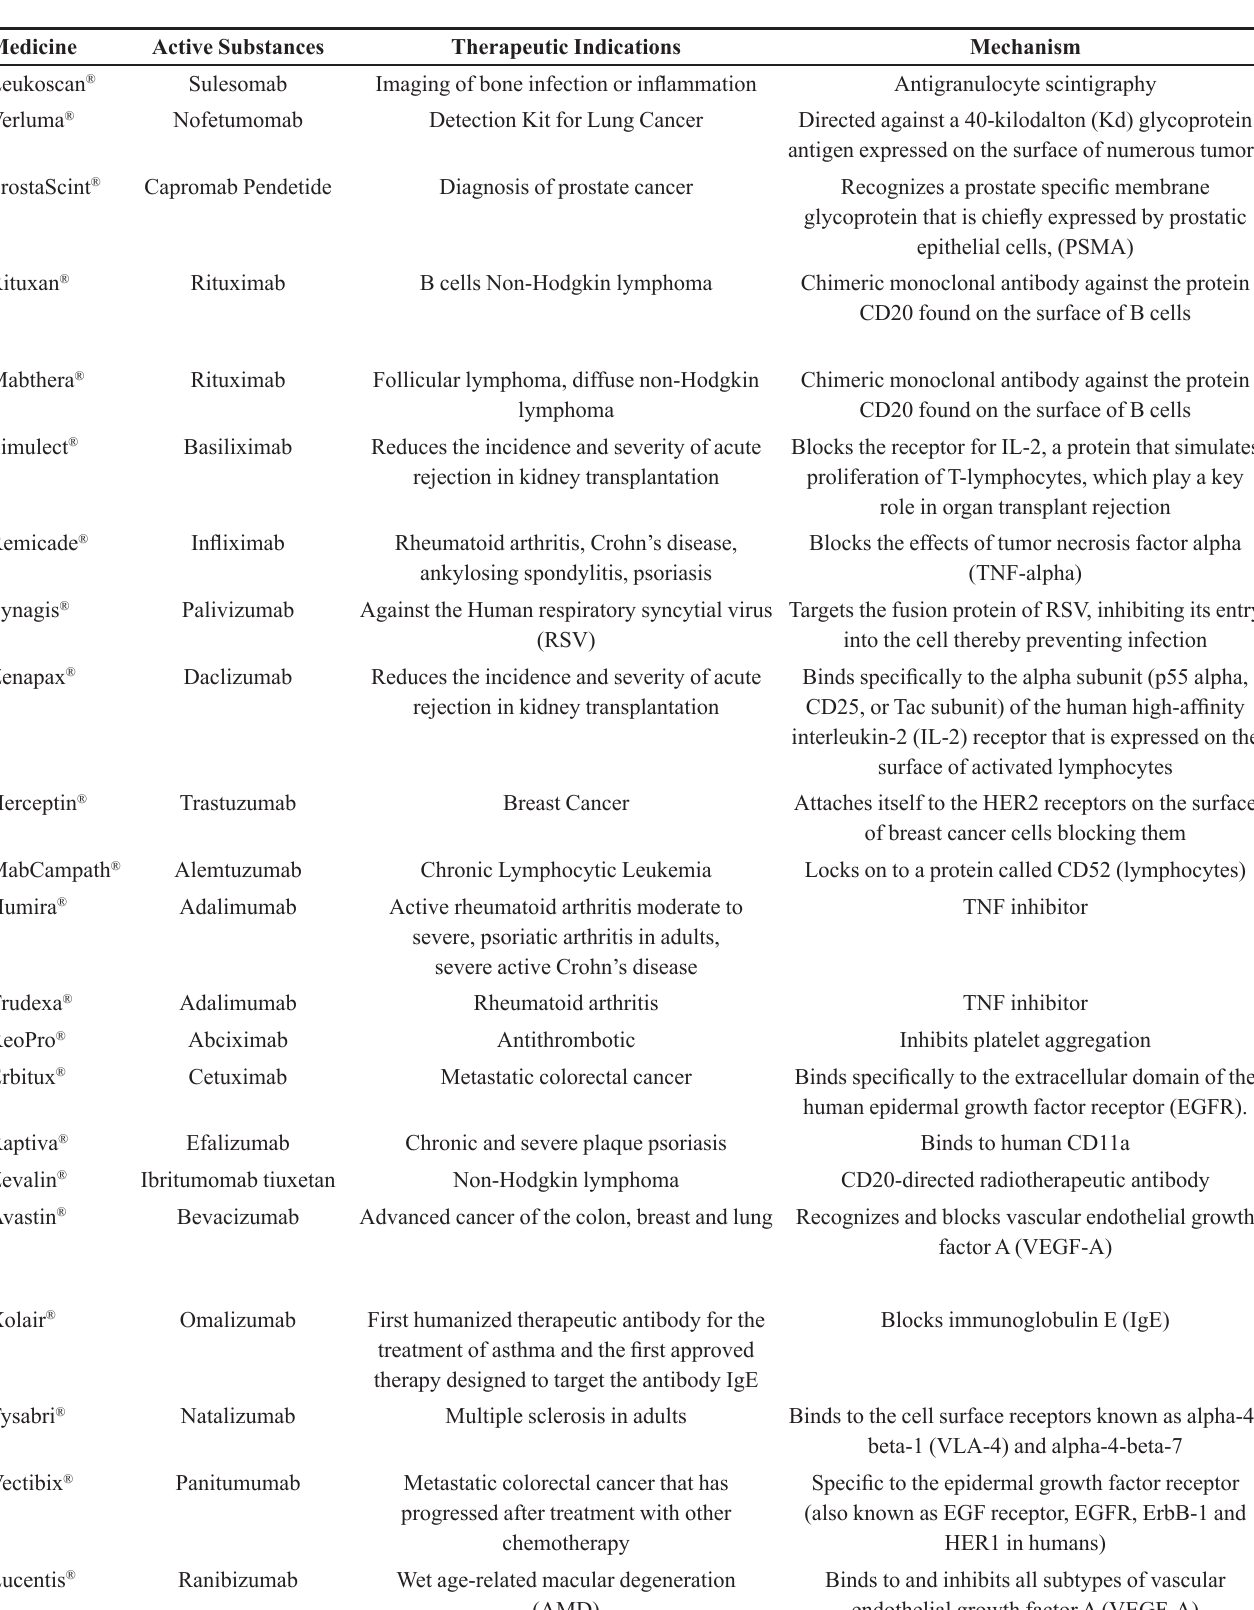
TABLE II – Examples of monoclonal antibodies on the market and their therapeutic